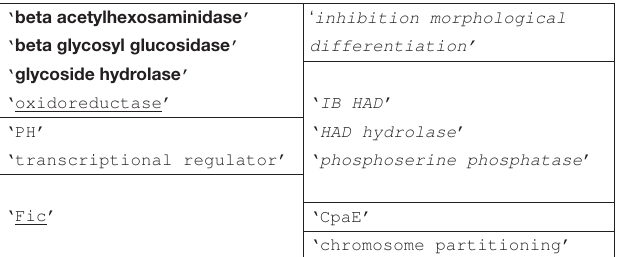
The phrases in Table 3 yielded synteny hits into another